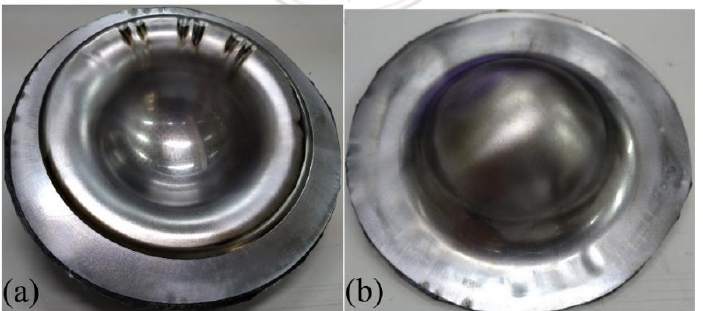
Figure 17. Deep drawing of steel-composite sandwich with blank-holding pressure of 4.0 MPa: ( a ) front view, ( b ) back view.